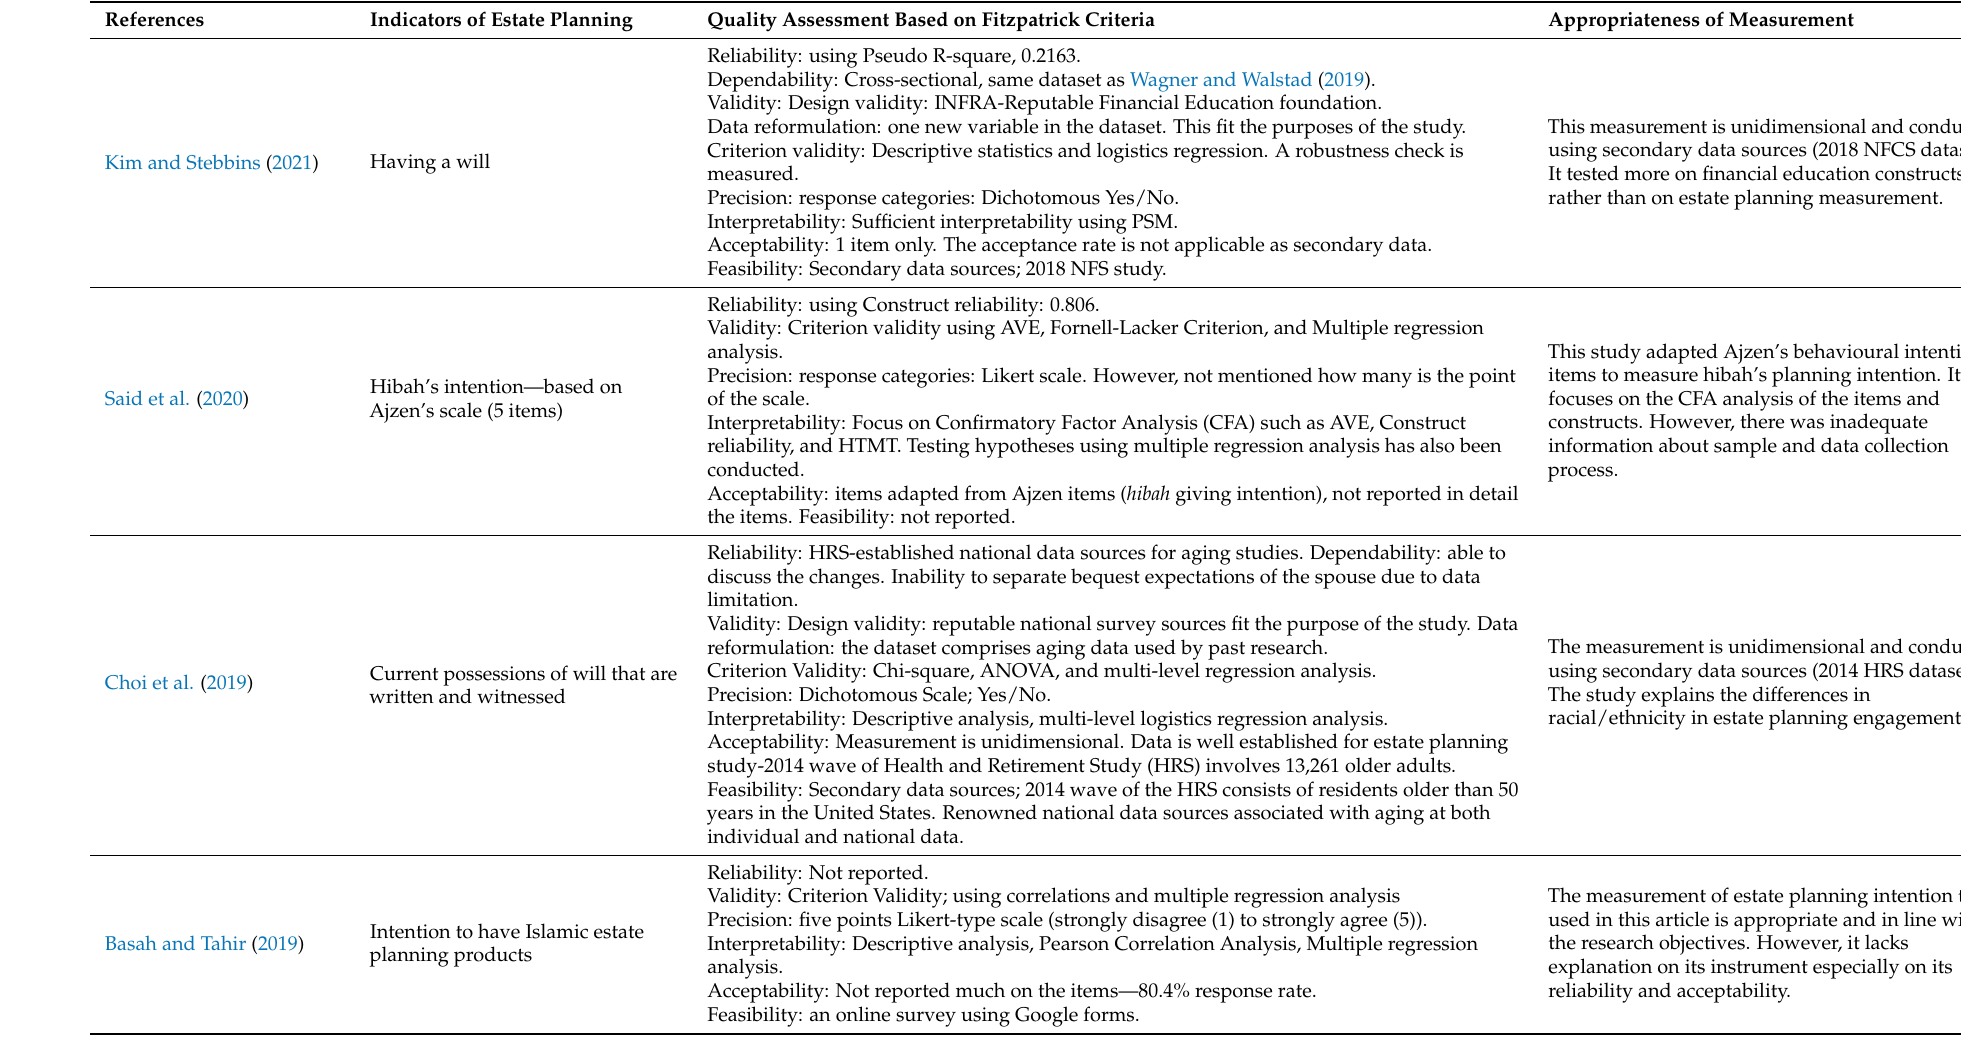
Table 6. Quality assessment of estate planning measurement instrument based on information provided in referenced